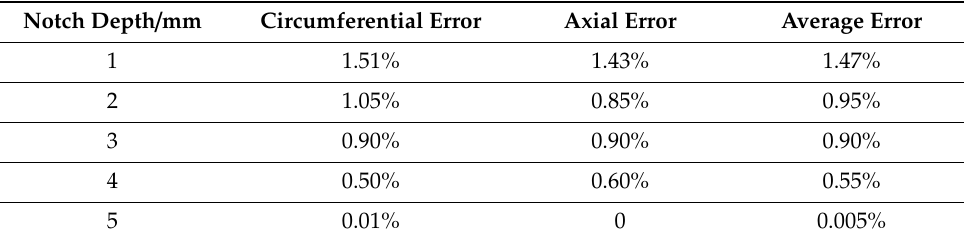
Table 3. Localization errors of curved plates with di ff erent notch depths.